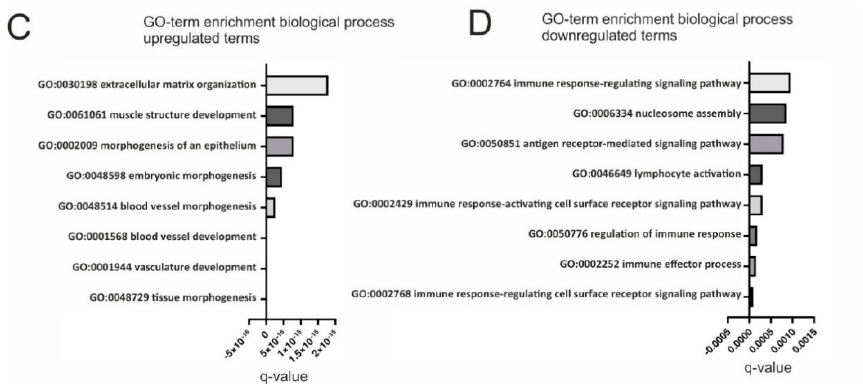
Figure 5. Comparison of ITSCs and hCSCs with HSCs by differential gene expression analysis. ( A ) Volcano plot shows 16,129 genes to be significantly ( q < 0.05) differentially expressed (green dots) in hCSCs and ITSCs compared to HSCs. ( B ) Top ten of the most significantly upregulated KEGG pathways in hCSCs and ITSCs ( q < 0.05). ( C ) Top ten of the most significantly enriched GO-terms in hCSCs and ITSCs ( q < 0.05). ( D ) Top ten of the most significantly enriched GO-terms in HSCs ( q <